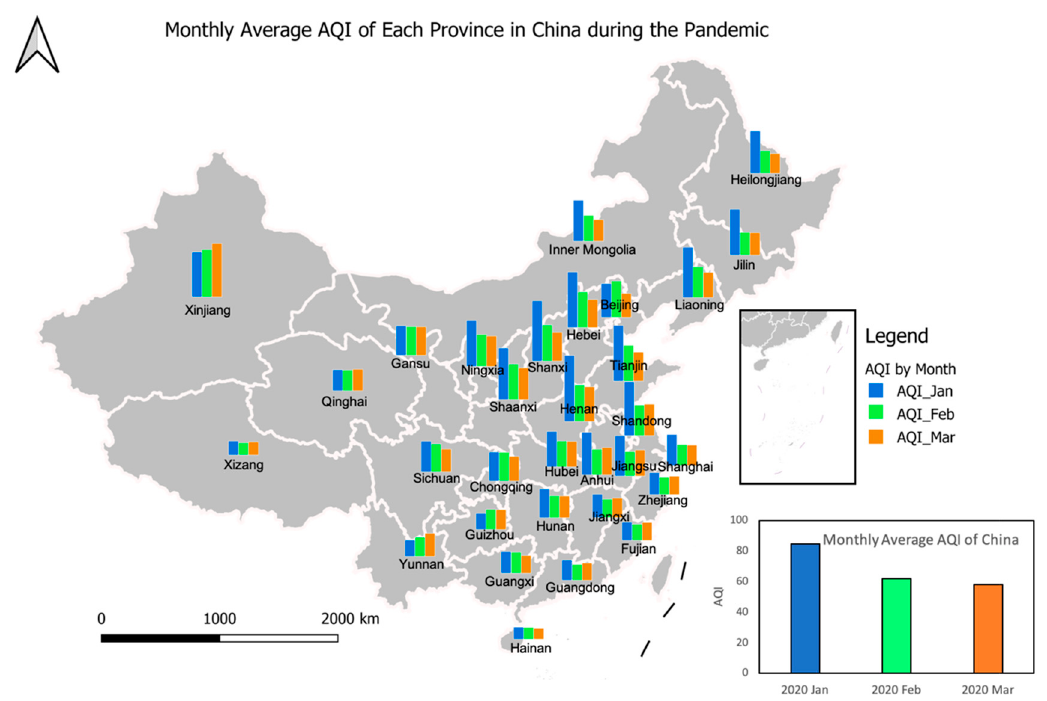
Figure 7. Monthly average AQI of each province and mainland China (lower right corner) from